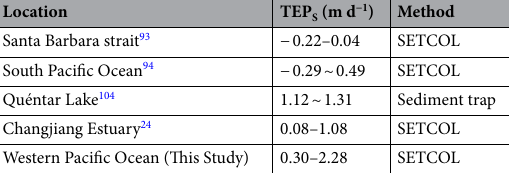
Table 3. Variations in TEP S and applied methods from different